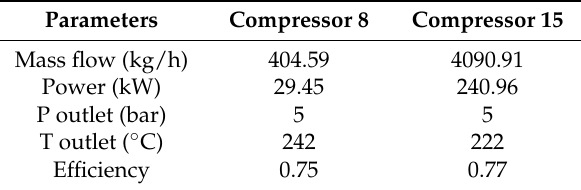
Table 7. Compressors’ performance.